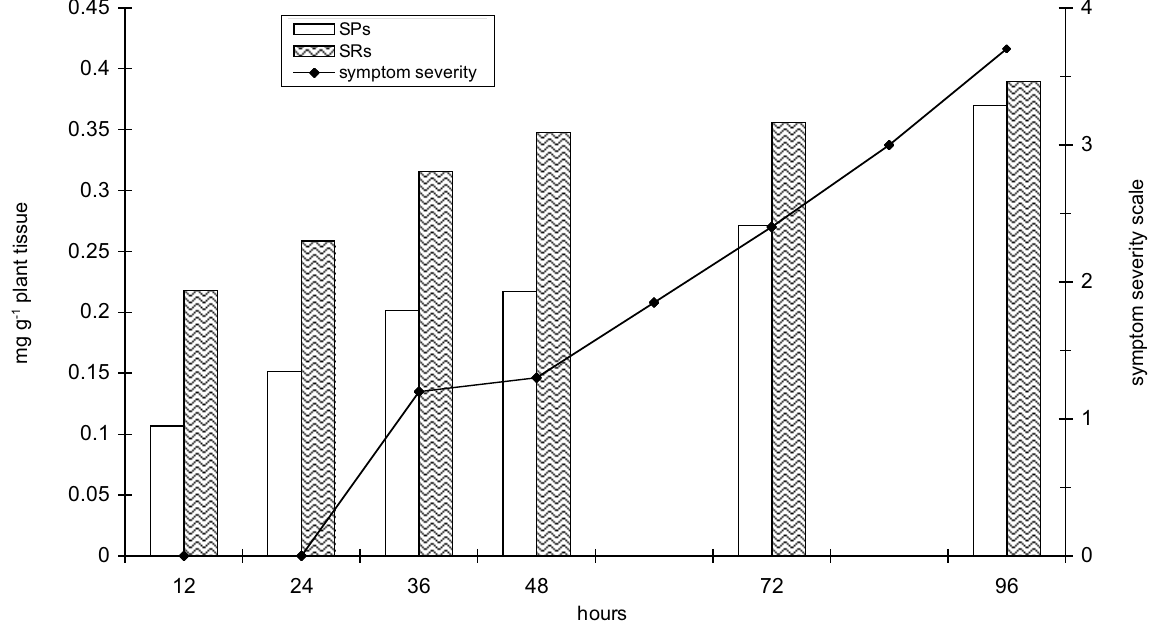
Fig. 2. Time course of the infection on zucchini cotyledons by P. syringae pv. lachrymans strain S91. The scale on the left indicates the concentration of LDP; that on the right refers to symptom severity (see Materials and methods). Values are the means of 3